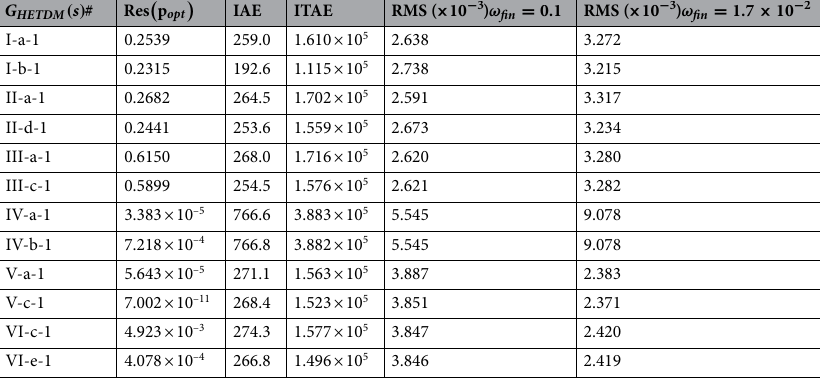
Table 8. HETDM time-domain and frequency-domain model errors (ad Table